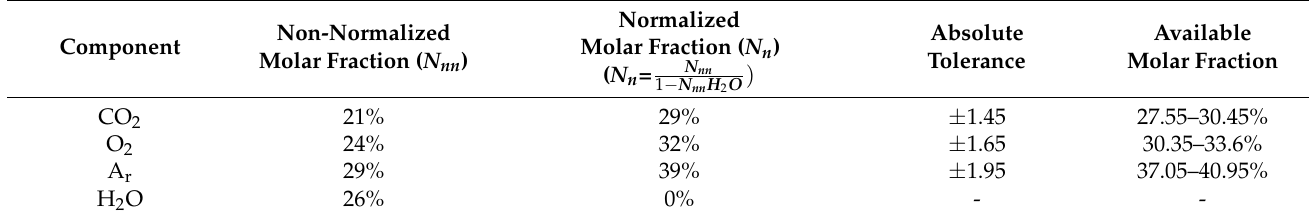
Table 1. The actual filled molar fraction values of carbon dioxide, oxygen, and argon.